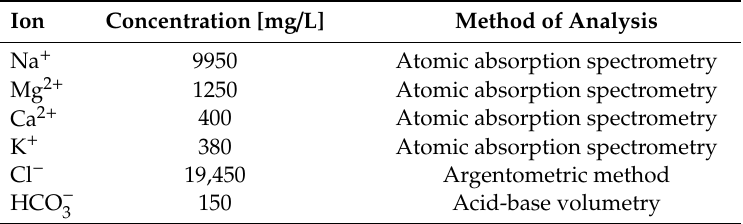
Table 4. Major composition of seawater from San Jorge Bay,